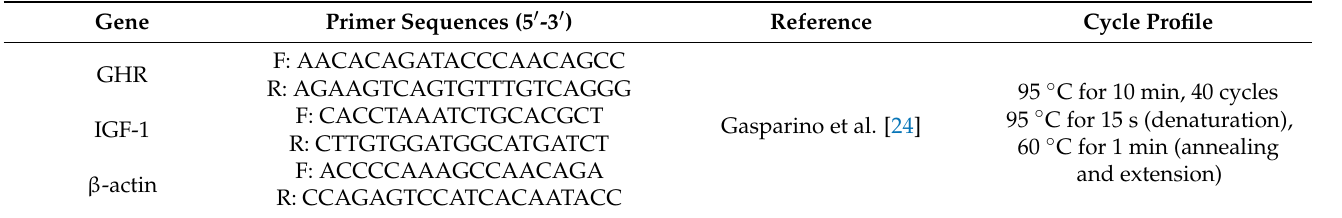
Table 2. Primer sequences for mRNA expression